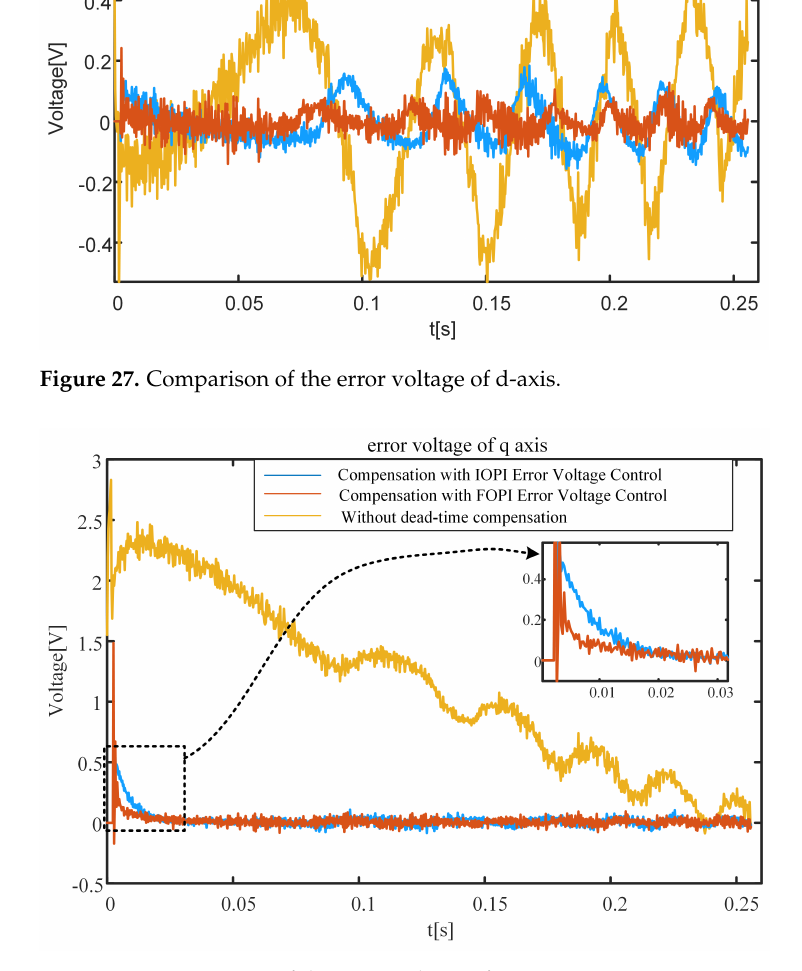
Figure 28. Comparison of the error voltage of